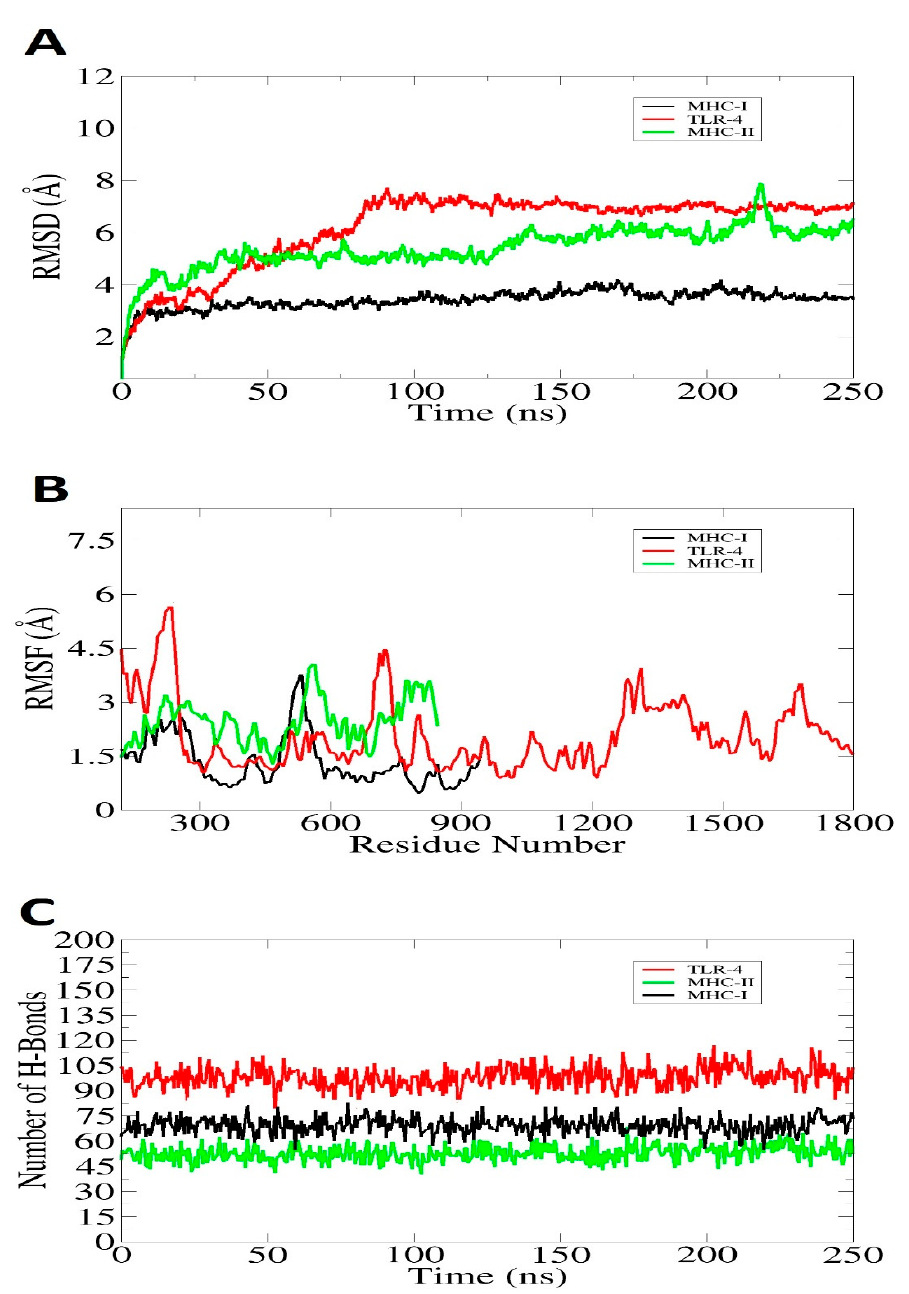
Figure 12. Simulation trajectories analysis via: RMSD ( A ), RMSF ( B ), and number of Hydrogen bonds ( C ).